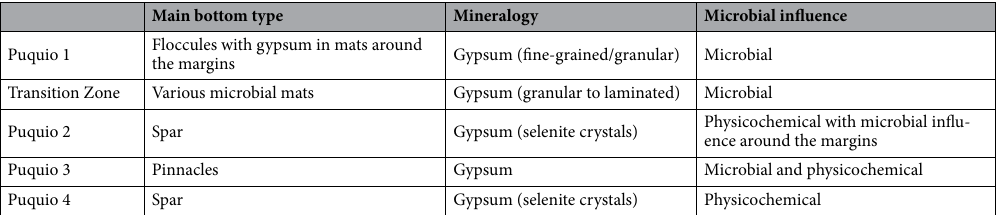
Table 1. Summary table showing main bottom type, dominant mineralogy, and interpretation of microbial influence in precipitation across the